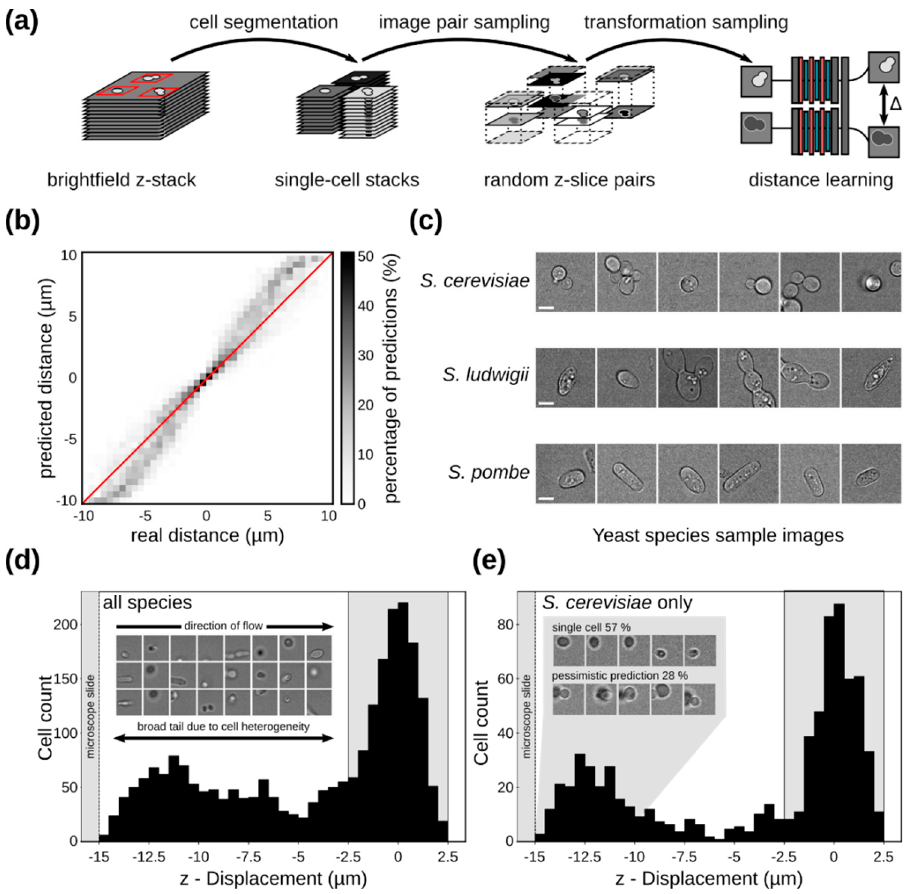
Figure 6. ( a ) Work flow underlying distance learning for automated z-position determination of flowing cells. Stacks of images of large fields of view containing many cells were recorded on the same microscope used for the imaging of flowing cells, but using an ordinary mounting of the cells. Single-cell stacks were cropped out. Random image pairs with known z-distances taken from single-cell stacks were used after image augmentation to train a Siamese neural network. ( b ) Predicted and real z-distance in pairs of cells taken from a test set of single cell stacks. ( c ) Images of the di ff erent yeast species used. ( c ) Example images of S. cerevisiae , S. ludwigii and S. pombe cells. The example cells highlight the high within-species and inter-species heterogeneity of the cells used. Scale bar length corresponds to 5 µ m. ( d , e ) Histogram of z-displacement of flowing yeast cells in the device relative to an in-focus reference cell. Bins have a width of 0.5 µ m, with the x-axis the z-displacement relative to the distribution median. Across all yeast species, example images highlighting their heterogeneity are shown. The shaded region within 2.5 µ m of the focal plane contains 51% and 60% of imaged cells for all species ( d ) and S. cerevisiae ( e ) respectively. S. cerevisiae examples of non-budding cells and pessimistic predictions in the region below − 10 µ m are shown, accounting for 85% of the distributions lower peak.